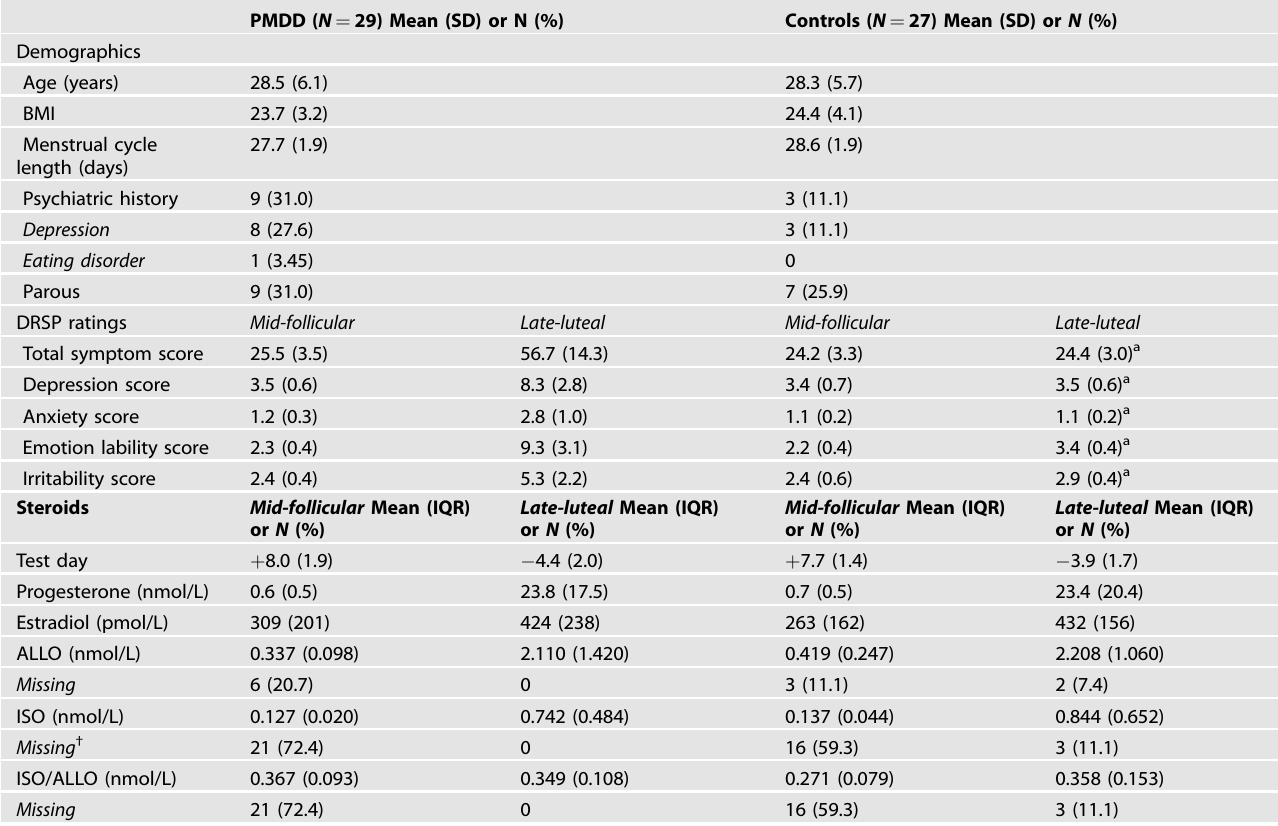
Table 1. Baseline characteristics of participants with PMDD and